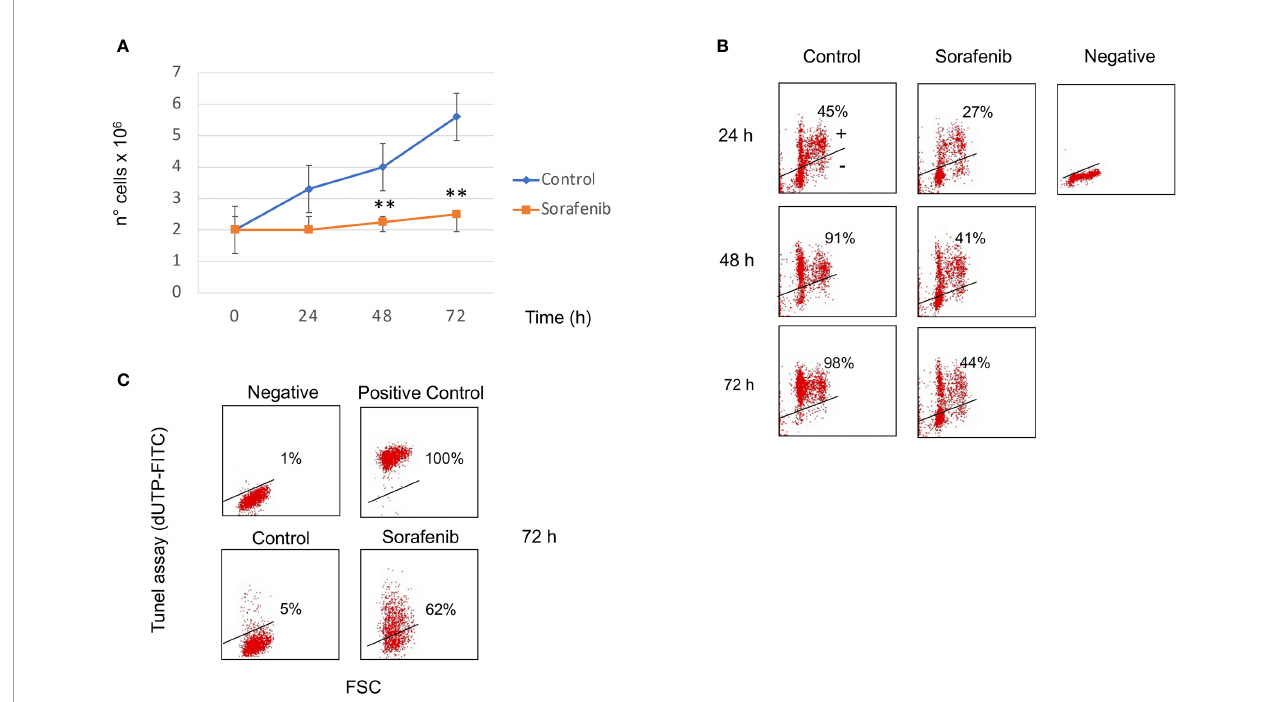
FIGURE 1 | Sorafenib inhibits cell growth and cell proliferation. Viability curves of untreated and treated H295R cells with 5 µM sorafenib for 72 hours. Cell growth inhibition progressively increases and, at the highest concentration at 72 h, reaches 42% of inhibition after sorafenib treatment. The results represent the mean ± s.d. of three independent experiments done in duplicate. A comparison of the individual treatment was conducted by using ANOVA followed by the Tukey – Kramer post hoc test. ** P < 0.01 vs Ctrl (A) . Analysis of BrdU incorporation in control and in treated cells for 24h, 48h and 72 hours respectively. In samples treated with sorafenib about 40% BrdU incorporation was evident at 48-72 h of treatment. Representative results are shown, and were quanti fi ed from three independent experiments; each group was analyzed in duplicate (B) . TUNEL assay to evaluate induction of apoptotic cell death in H295R cells by sorafenib treatment. Flow cytometric analysis of untreated and treated cells with sorafenib for 72 h. At this time 62% of treated cells were dUTP-FITCH positive revealing apoptotic cell death. Similar results were obtained in three independent experiments (C)